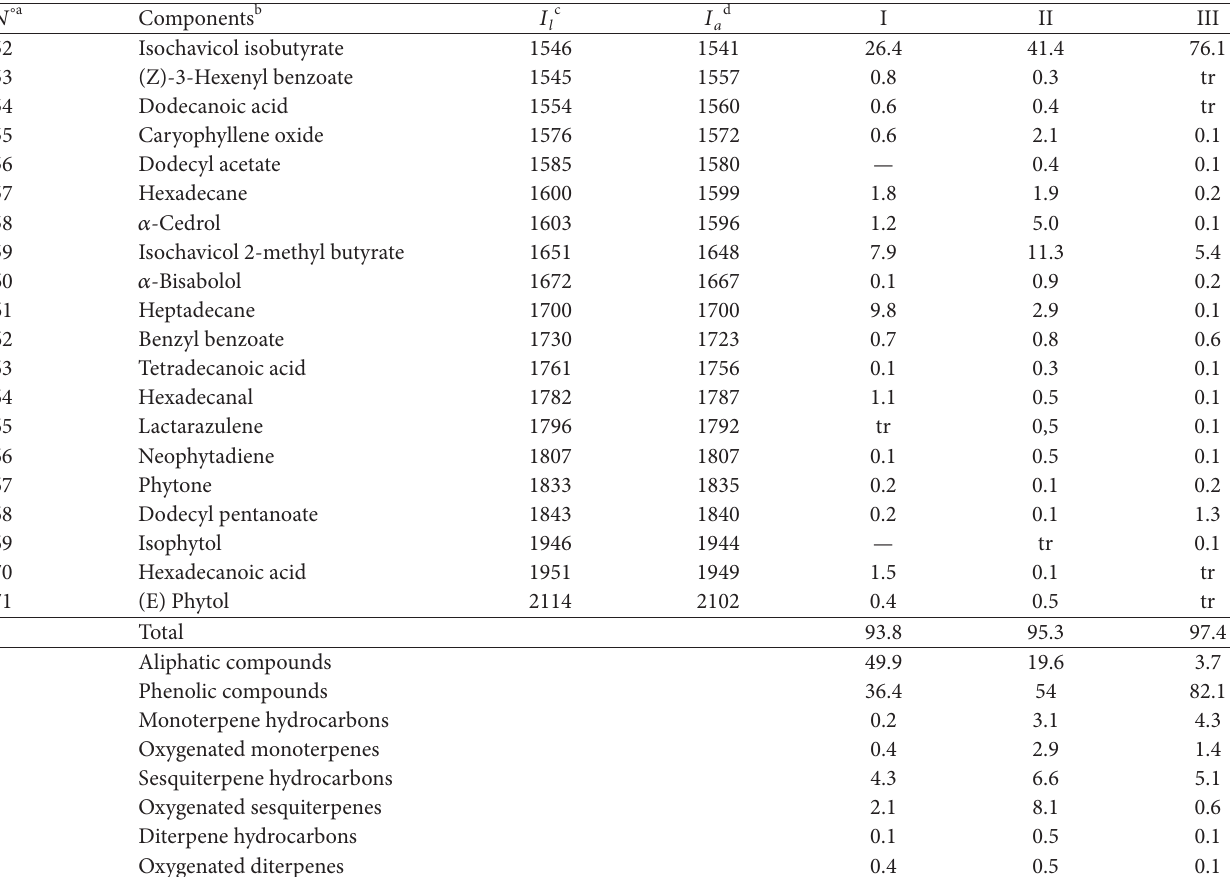
T 3: Antimicrobial activity of the essential oils of aerial parts of D. crinitus . Microorganisms